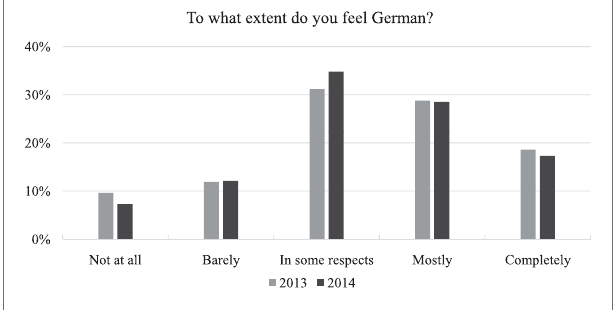
FIGURE 1 | National identi fi cation in the years 2013 and